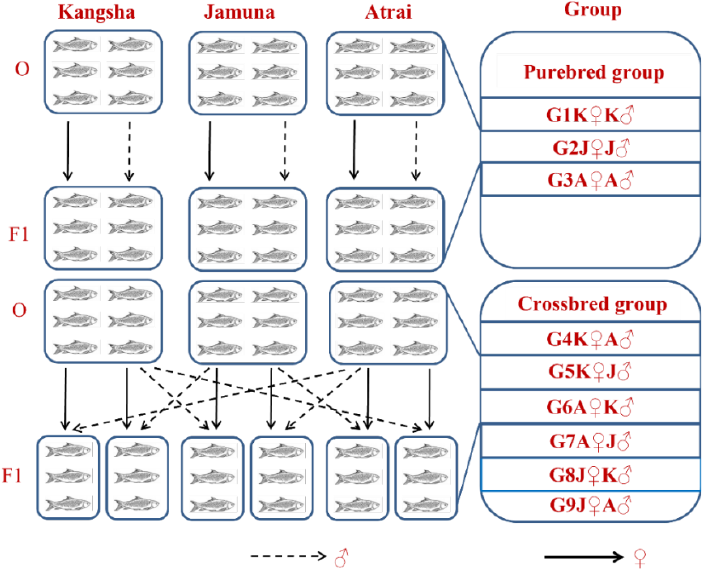
Figure 2. Inter- and intra-species ordination of different sample populations of Ariza labeo ( L. ariza ) to propagate and procreate F1 generation. The single words picked for naming the purebred and crossbred groups bear the full forms as G → Group, K → Kangsha River stock, J → Jamuna River stock and A → Atrai River stock.